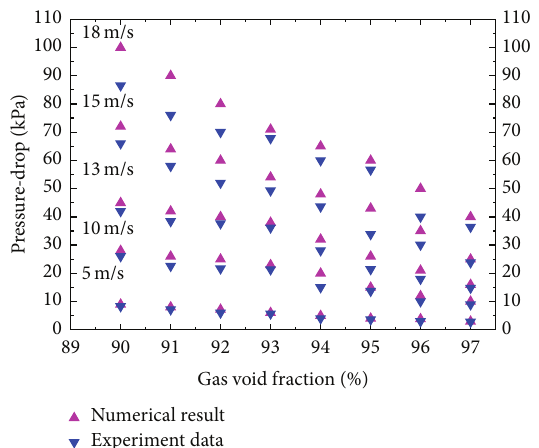
Figure 16: The comparison of pressure-drop between experiment data and numerical result under different